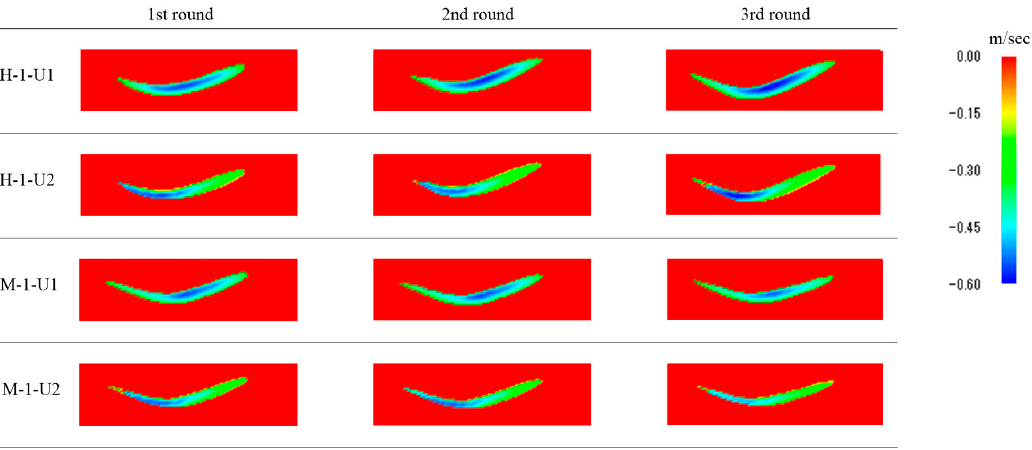
Figure 10. Average horizontal flow velocity distribution. The flow velocity is expressed as negative because the right direction is positive: 1 is u n , and 2 is u n + 1 . Geosciences 2019 , 9 , x FOR PEER REVIEW